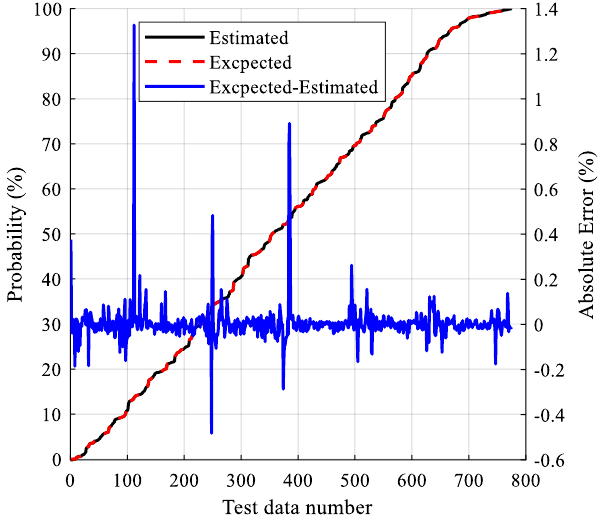
Figure 9. Comparing the results of the estimated quench probability versus expected values based on the absolute error index.